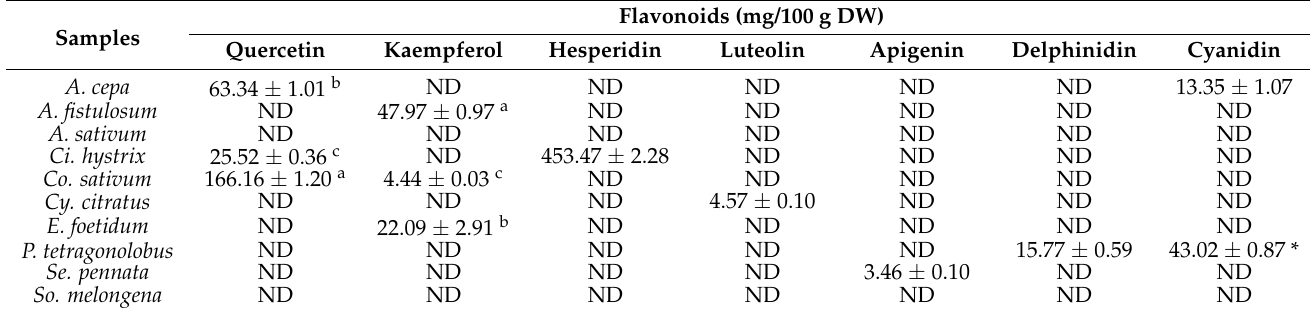
Table 1. Profiles and quantification of flavonoids in the plant